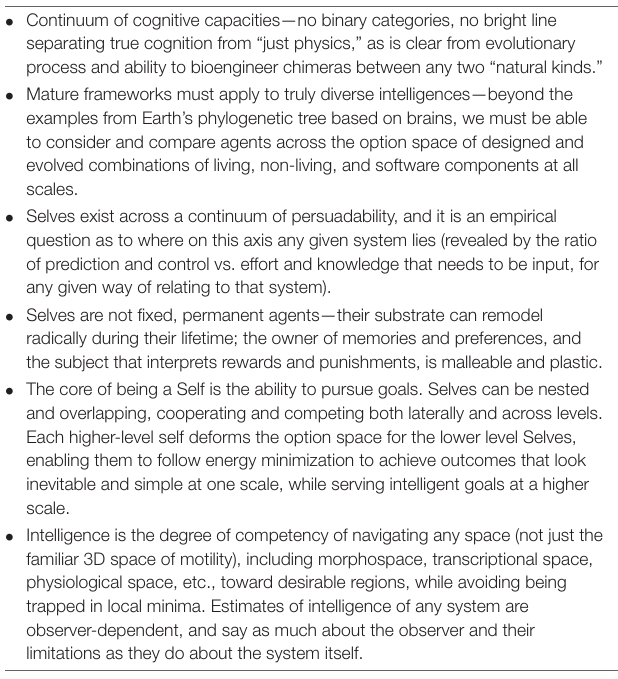
TABLE 1 | The core tenets of